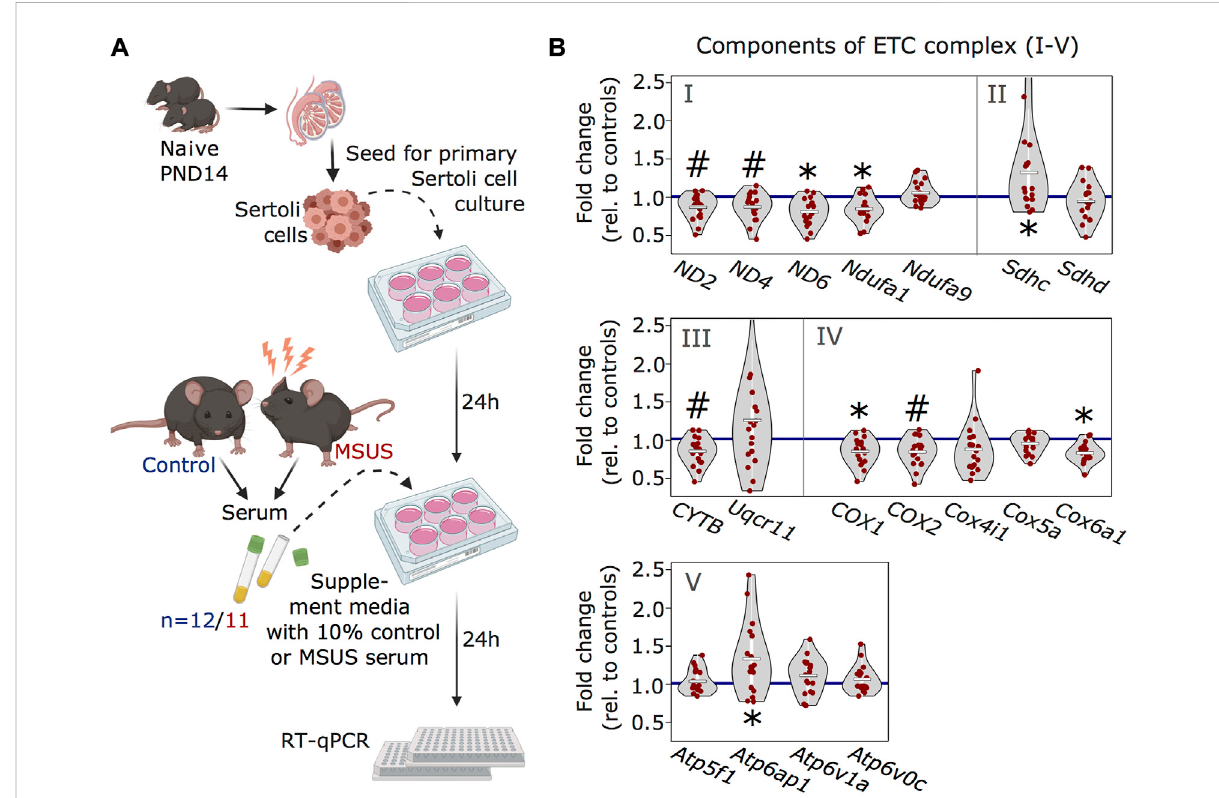
FIGURE 4 Analyses of ETC genes in primary Sertoli cells after MSUS serum exposure. (A) Schematic representation of the experimental strategy for serum treatment of Sertoli cells. Primary Sertoli cells from naïve mouse pups (PND14) were seeded and treated with 10% serum from control (blue) and MSUS(red)micefor24 h.TreatedcellswerethenharvestedforRT-qPCR.Controls, n =12;MSUS, n =11.Experimentwasperformedinduplicates. (B) RT-qPCRofETCcandidategenesinserumtreatedSertolicells.CandidategenesaredividedaccordingtoETCcomplexes(I,II,III,IV,V)andfold changeofexpressionpro fi lesisshownforMSUSsamplesrelativetocontrolmean(blueline)ofrespectivegenes.MeanofMSUSsamplesdepictedas white line, individual samples as red dots. * p < 0.05, # p < 0.1, Kenward Roger